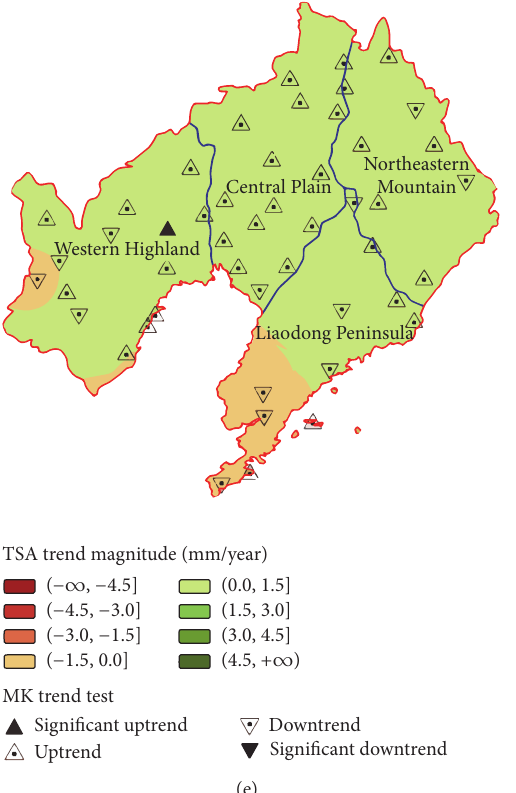
Figure 4: Spatial distribution patterns of precipitation trends and the significance for 49 selected meteorological stations at annual and seasonal time scales: (a) annual, (b) spring, (c) summer, (d) autumn, and (e) winter precipitation. TSA indicates the Theil-Sen